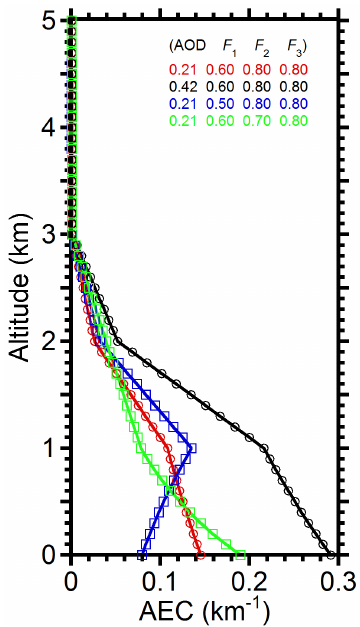
Figure 1. Examples of aerosol extinction coefficient (AEC) profiles retrieved from MAX-DOAS observations. These are derived from four parameters of AOD, F 1 , F 2 , and F 3 , as described in detail in the text. Parameters used are given in the